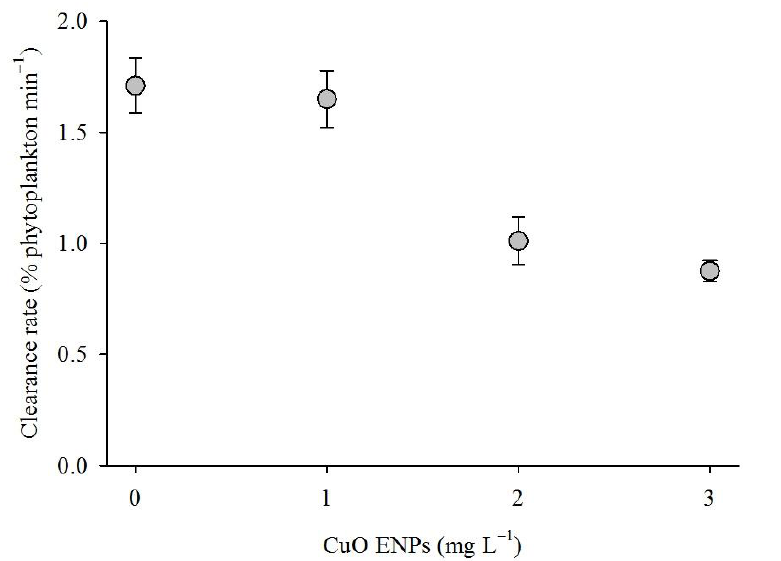
Figure 1. Feeding rate of mussels exposed to CuO engineered nanoparticles (ENPs). Mean feeding rate for mussels exposed to CuO ENPs for four weeks. Feeding rate decreased with increasing CuO ENP concentration (ordinary least squares (OLS): Feeding = 1.99 × 10 −2 − 3.1 × 10 −3 (Concentration) − 8 × 10 −4 (Time), r 2 = 0.37). Error bars are one standard error of the